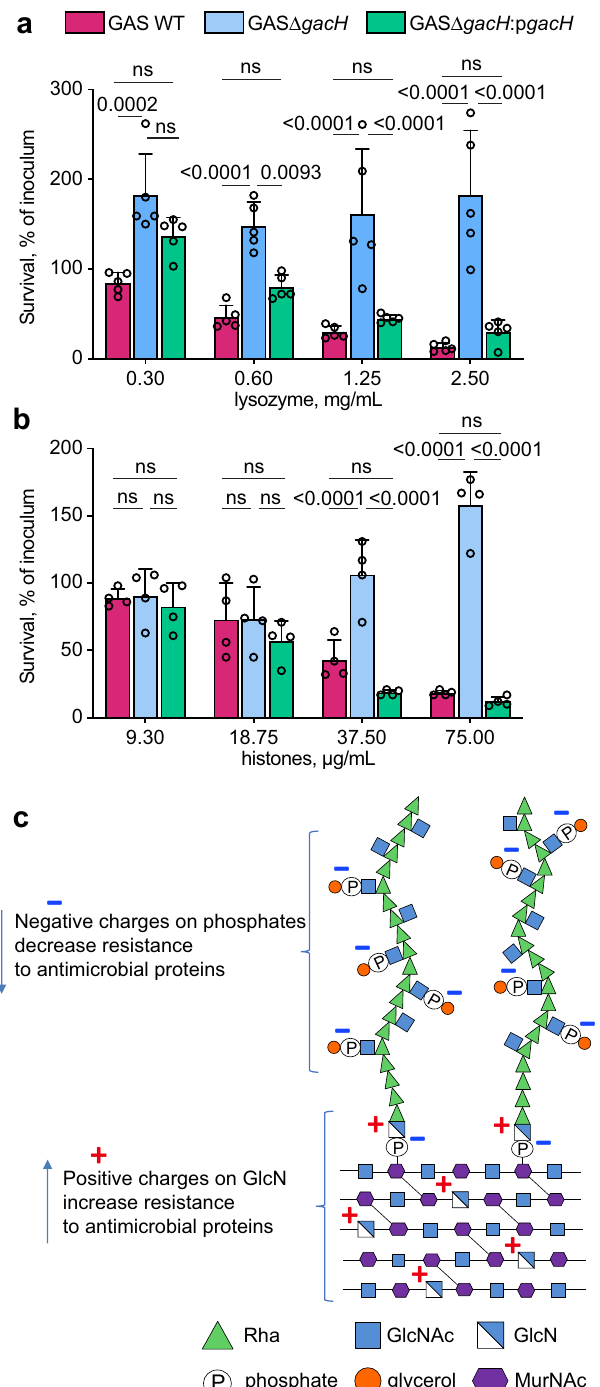
Fig. 7 The role of the GroP modi fi cation in GAS protection against histones and lysozyme. a , b Analysis of resistance of GAC mutants de fi cient in the GroP modi fi cation to a lysozyme, and b histone mixture. Data are mean values ± S.D., n = 5 biologically independent experiments in ( a ), n = 4 biologically independent experiments in ( b ). P values were calculated by two-way ANOVA with Bonferroni ’ s multiple comparison test. Source data for ( a , b ) are provided as a Source data fi le. c Introduction of charges to the GAS cell wall by GlcNAc deacetylation and GroP modi fi cation modulates resistance to host cationic antimicrobial